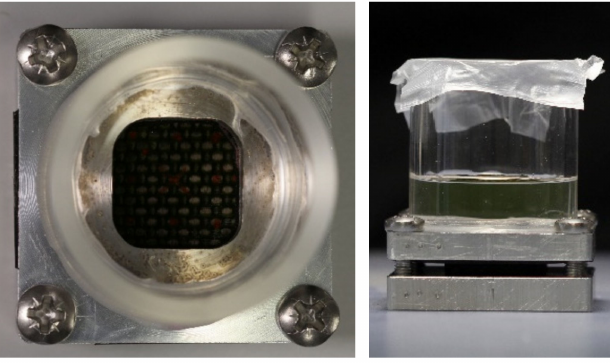
Figure 1. Sample holder for ageing in